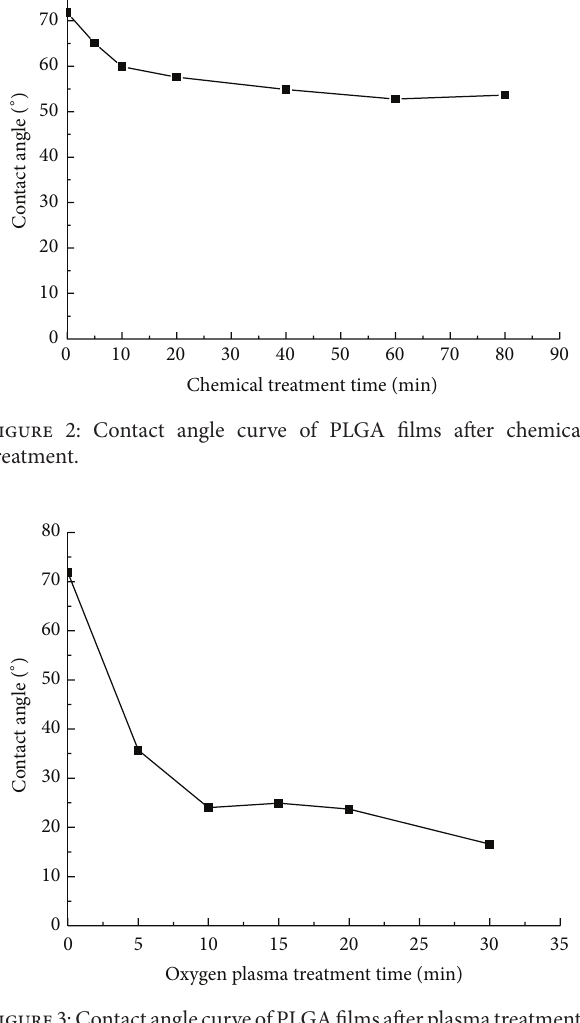
Figure3:ContactanglecurveofPLGAfilmsafterplasmatreatment.